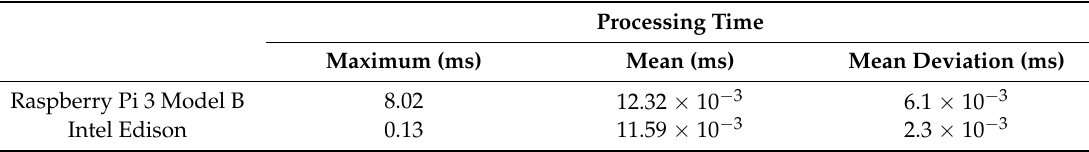
Table 6. Test 2. Processing time on Raspberry Pi 3 Model B and Intel